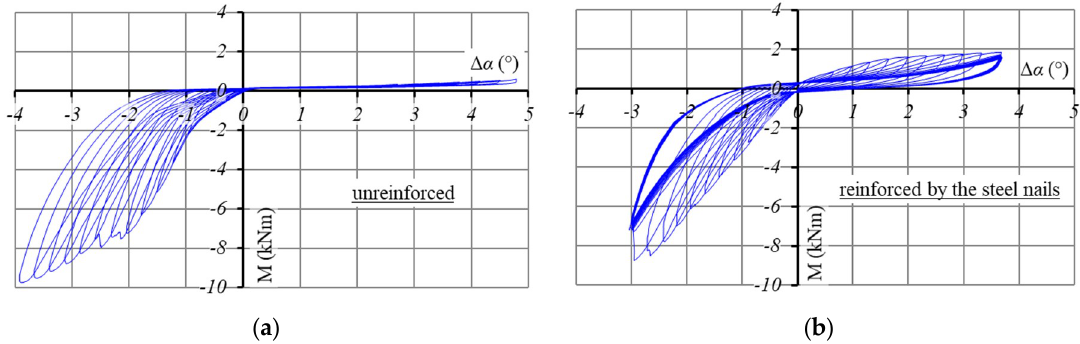
Figure 8. ( a ) Hysteresis loops of a joint before retrofitting with steel nails; ( b ) Hysteresis loops of a joint after retrofitting with steel nails.